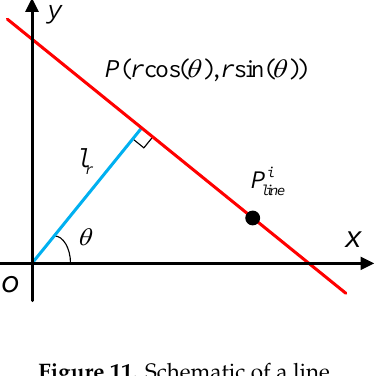
Figure 11. Schematic of a